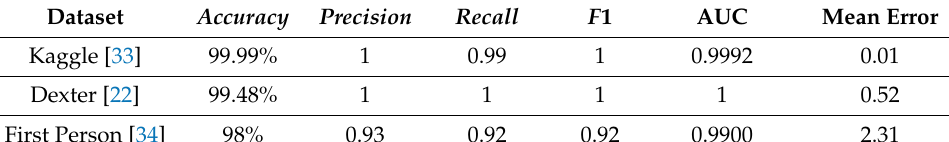
Table 5. Summary of testing results of the proposed methodology with three datasets.